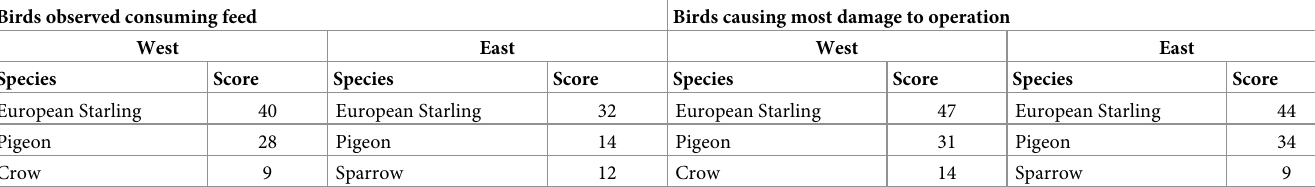
Table 3. Bird species ranked by feed consumption and overall damage to operation.